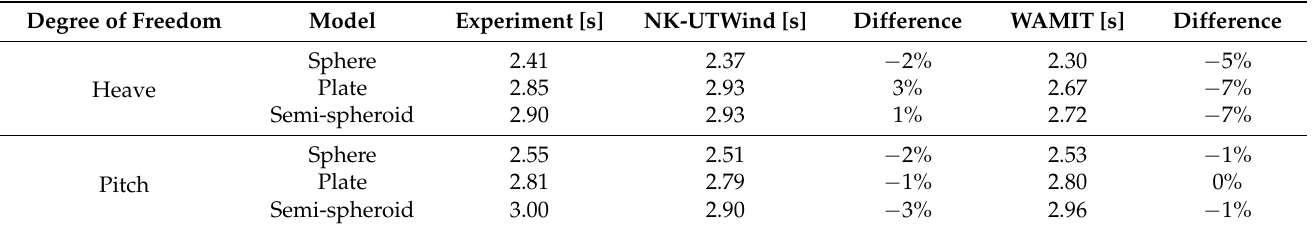
Table 9. Natural periods obtained from a peak of RAO result for medium regular wave height conditions.